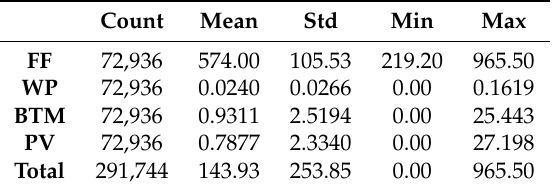
Table 1. Energy source-wise data summary.